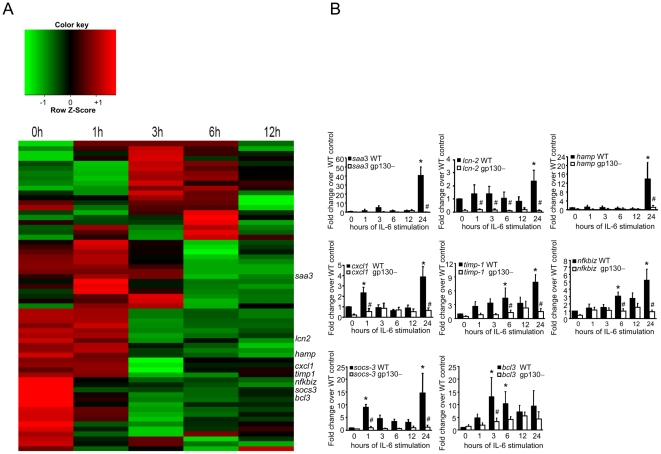
Co-expression analysis of gp130-regulated genes.(A) Time-course gene microarray analysis of hepatocytes for five different time points before and after IL-6 stimulation (n>5 per group). Genes with >1.5 and <−1.5 fold change after IL-6 stimulation were clustered in a heatmap diagram. Red indicates up-regulation compared with wild-type mice and green indicates down-regulation. (B) Quantitative real-time PCR of hepatocytes taken from untreated (control), gp130–and wildtype (WT; gp130 flox) mice after time-dependent IL-6 stimulation. * P<0.05. Data are presented as mean±SEM of at least 8 independent experiments.